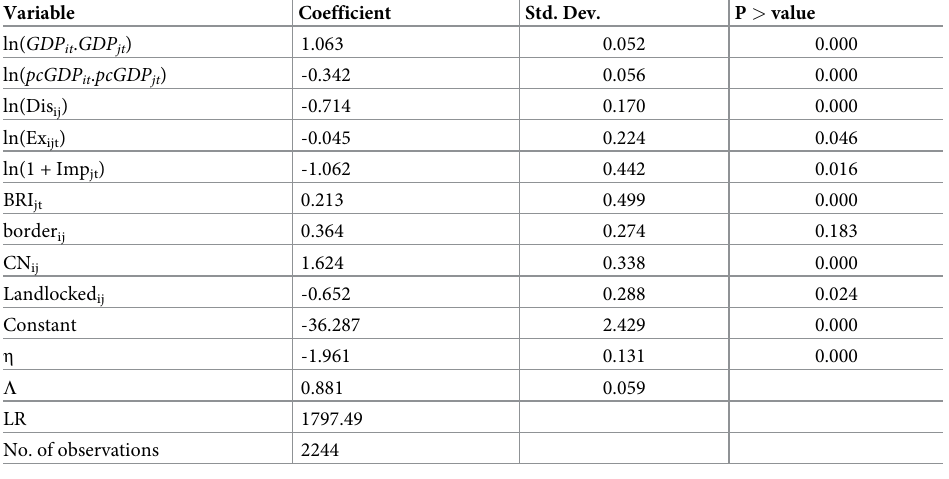
Table 4. Maximum likelihood estimates of the